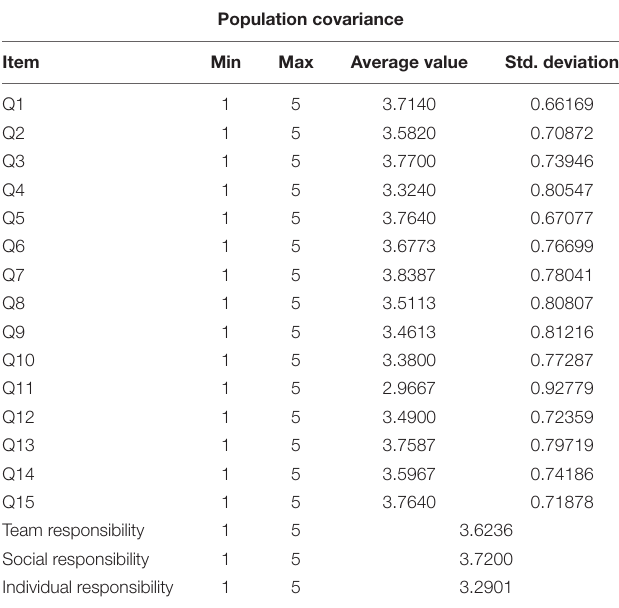
TABLE 3 | Responsibility of innovation and entrepreneurship of college student.